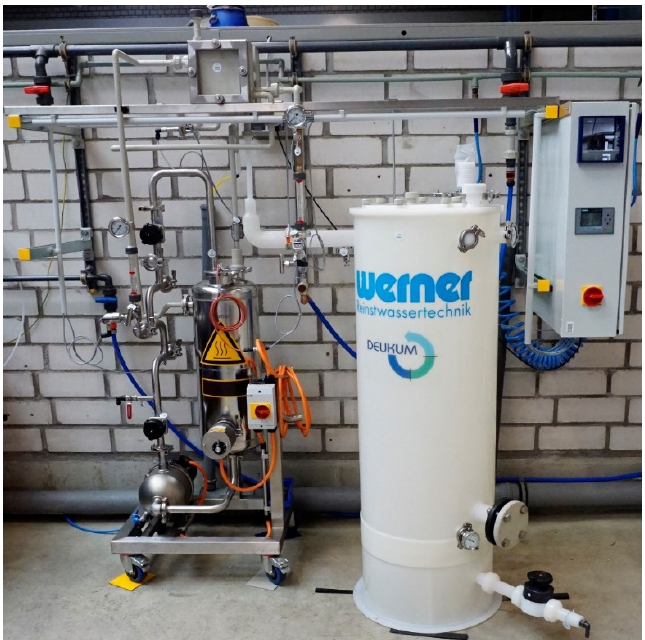
Figure 1. MD test plant.